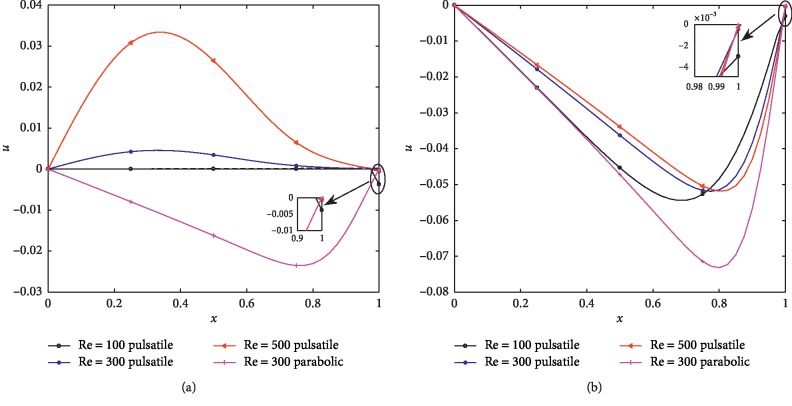
Radial velocity profiles for different Re at (δ1=0.2,  δ2=0.4) (a) z=10. (b) z=19.